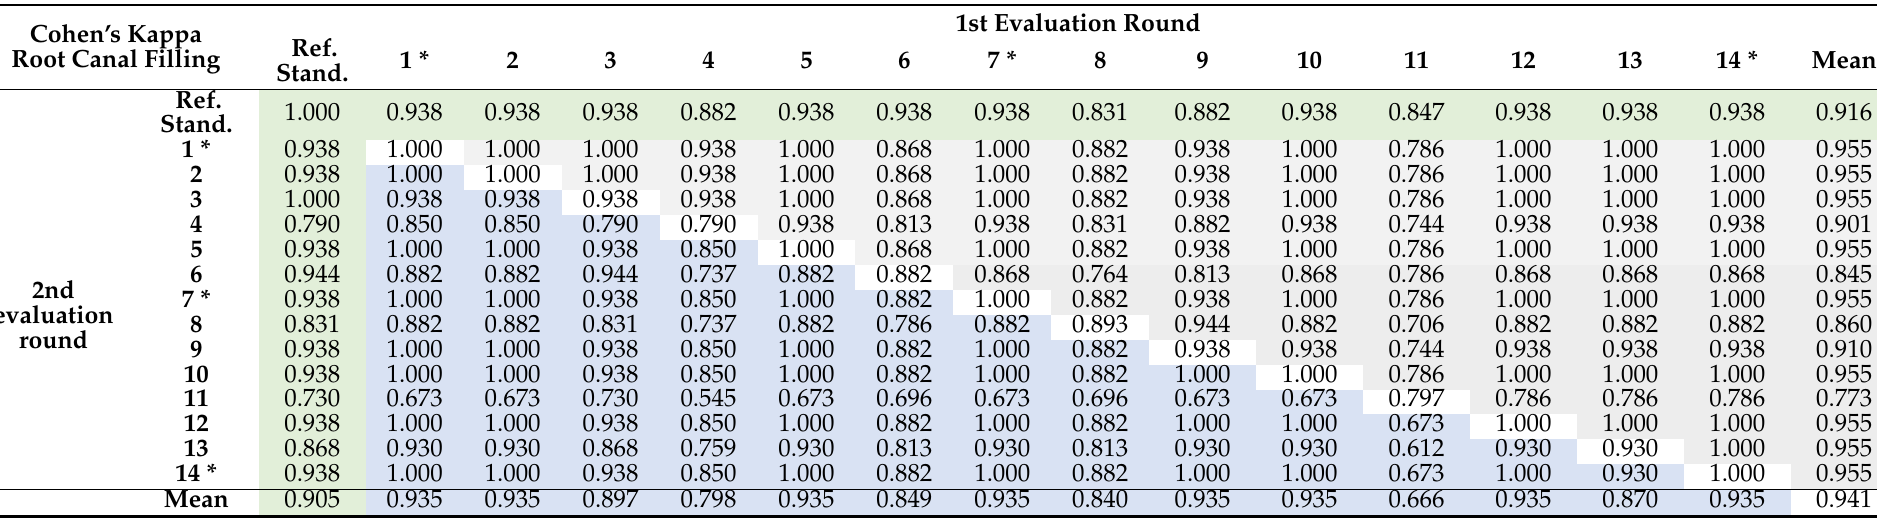
Table 3. Inter- and intra-examiner reliability values for the detection of root canal fillings between all examiners (N = 14) and in relation to the reference diagnosis (green background color). Gray background colors indicate inter-examiner CK values of the first evaluation round and blue background colors for the second evaluation round. Fields with a white background color represent intra-examiner CK